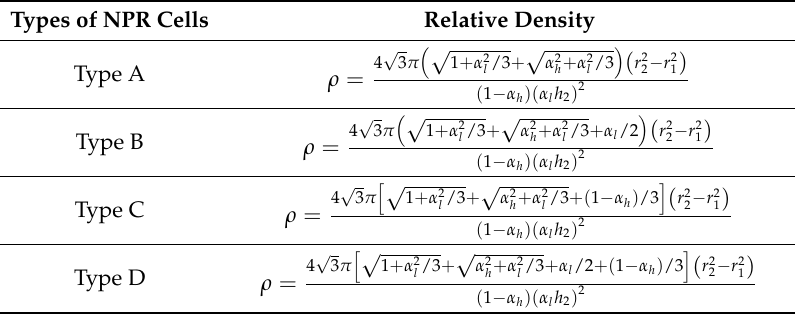
Table 1. The formula of relative density for four types of NPR lattices.